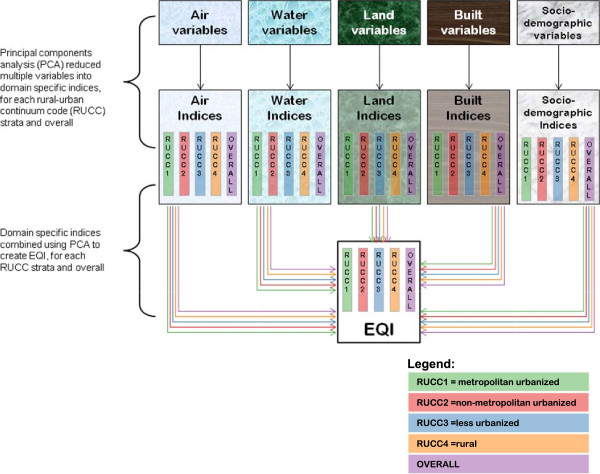
Domain-specific and overall EQI construction - conceptually.